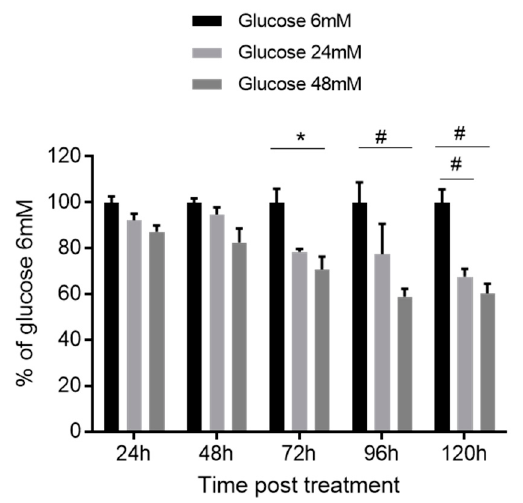
Figure 1. High glucose inhibits the proliferation of oral keratinocytes. TIGK cells were seeded in a 96 ‐ well plate. Twelve hours later, the media was switched to ones with higher concentrations of glucose (24 mM and 48 mM). Cell proliferation was examined using an MTS assay 24, 72, and 120 h after the treatment. Results are shown as the percent of OD 490 values of the 6 mM glucose treatment at each time point. There were 6 replicates in the low glucose group and 3 replicates in each high glucose group for each time point. * p < 0.05, # p < 0.01. One ‐ way ANOVA followed by Tukey’s post ‐ tests was used for statistical analysis.